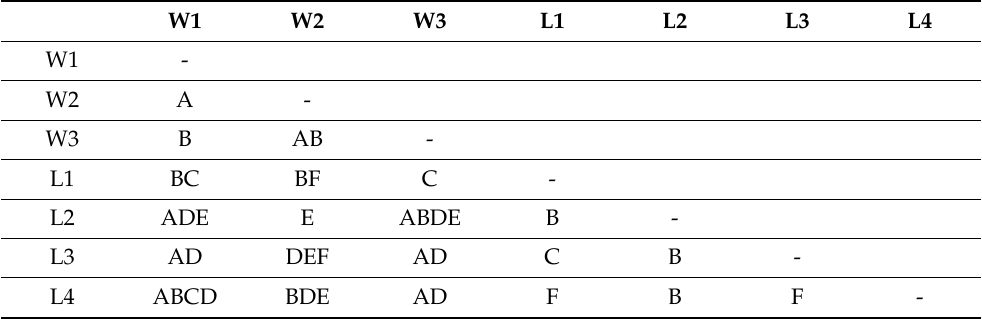
Table 2. Significant ( p < 0.05) Bonferroni-adjusted, between horse comparisons of combined fore